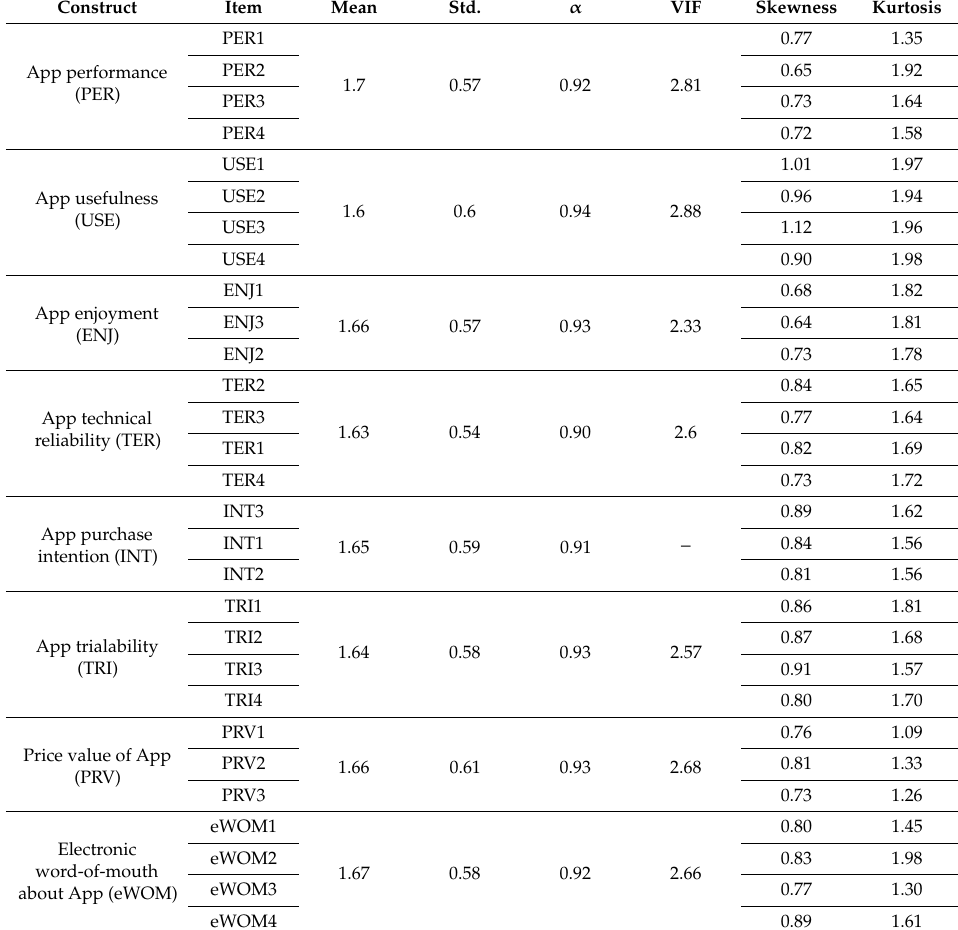
Table 5. Preliminary